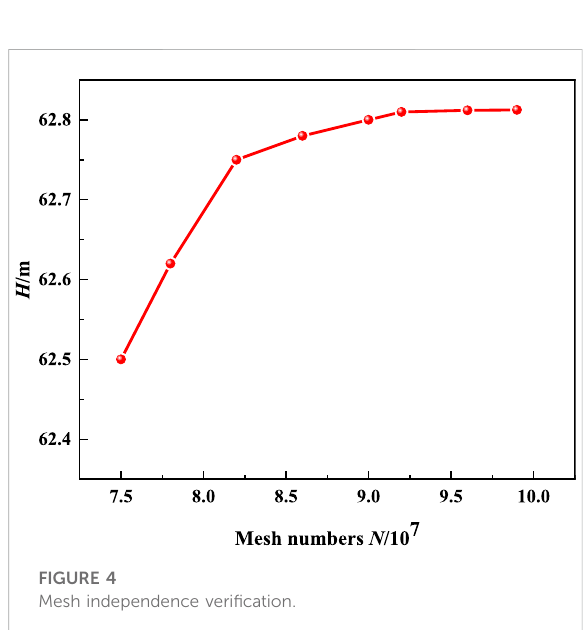
FIGURE 4 Mesh independence veri fi